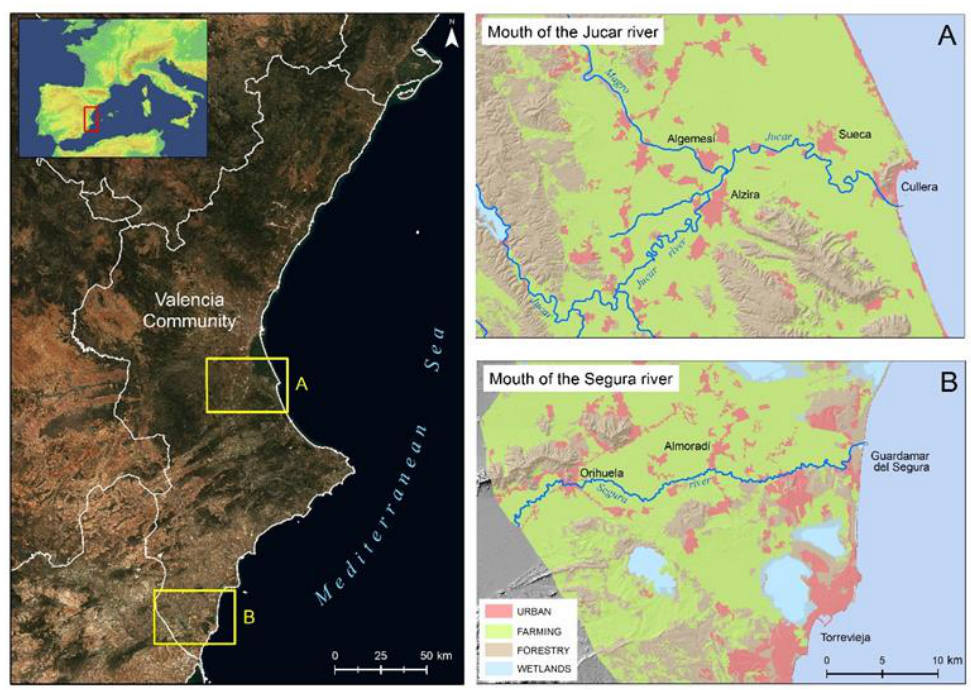
Figure 2. Study area (mouth of the Júcar River — Valencia) and the mouth of the Segura River — Vega Baja district) . Source: own elaboration.